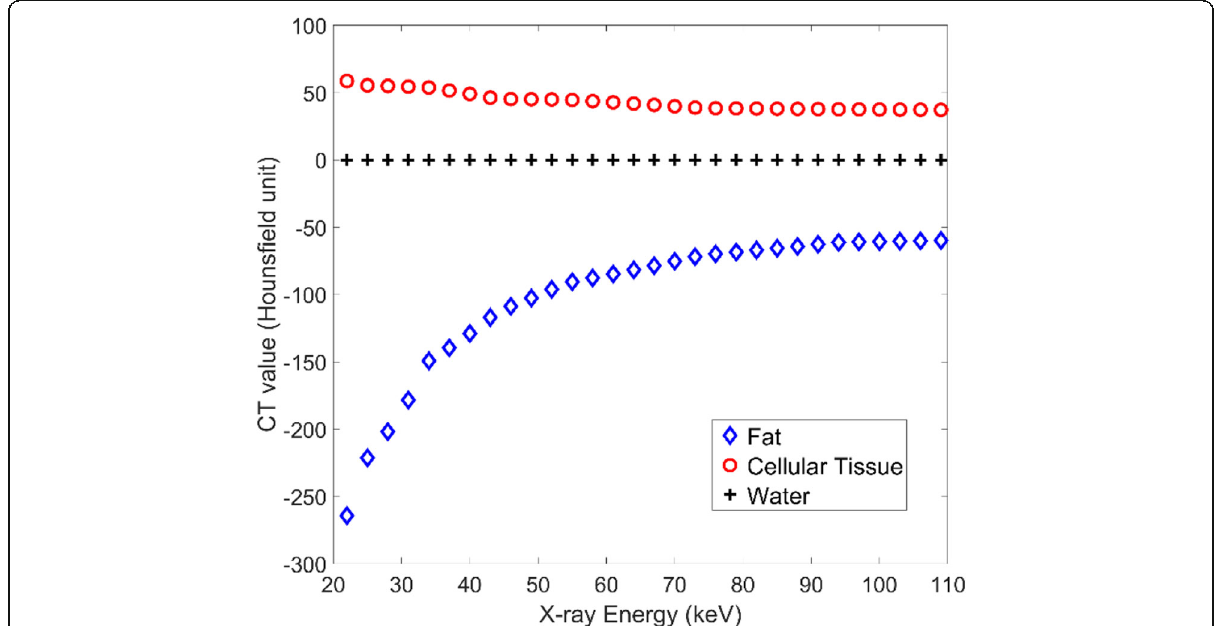
Fig. 6 Computed tomography values of three tissue types under different